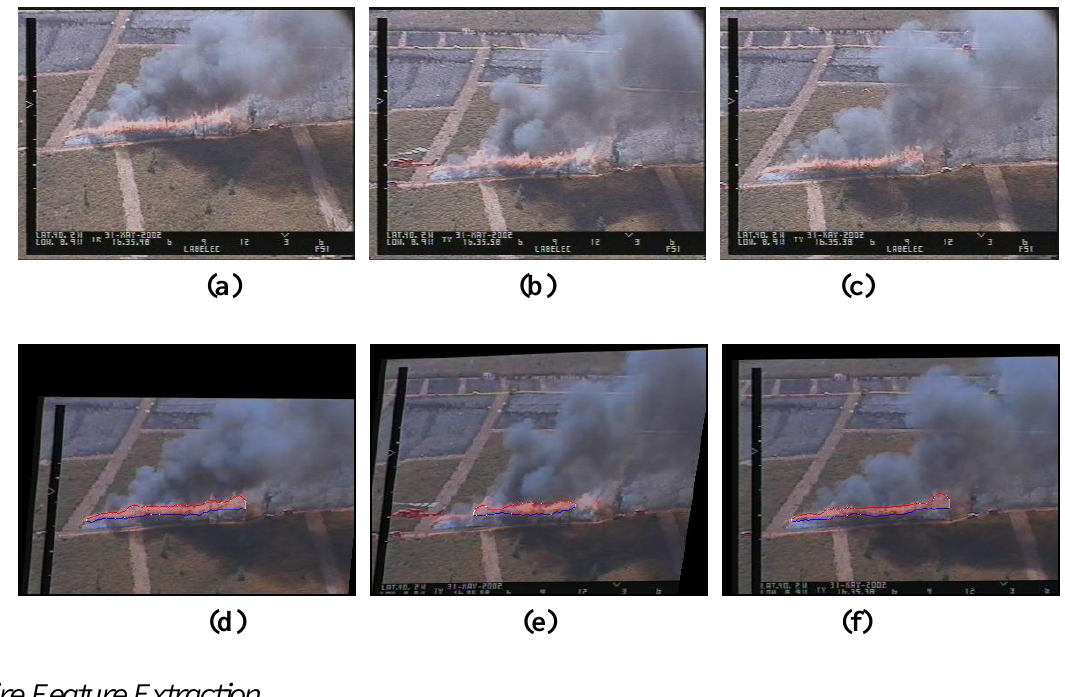
Figure 6. Image stabilization in three consecutive aerial images: (a–c) original consecutive aerial images with vibrations, (d–f) resulting images after vibration cancellation and extraction of